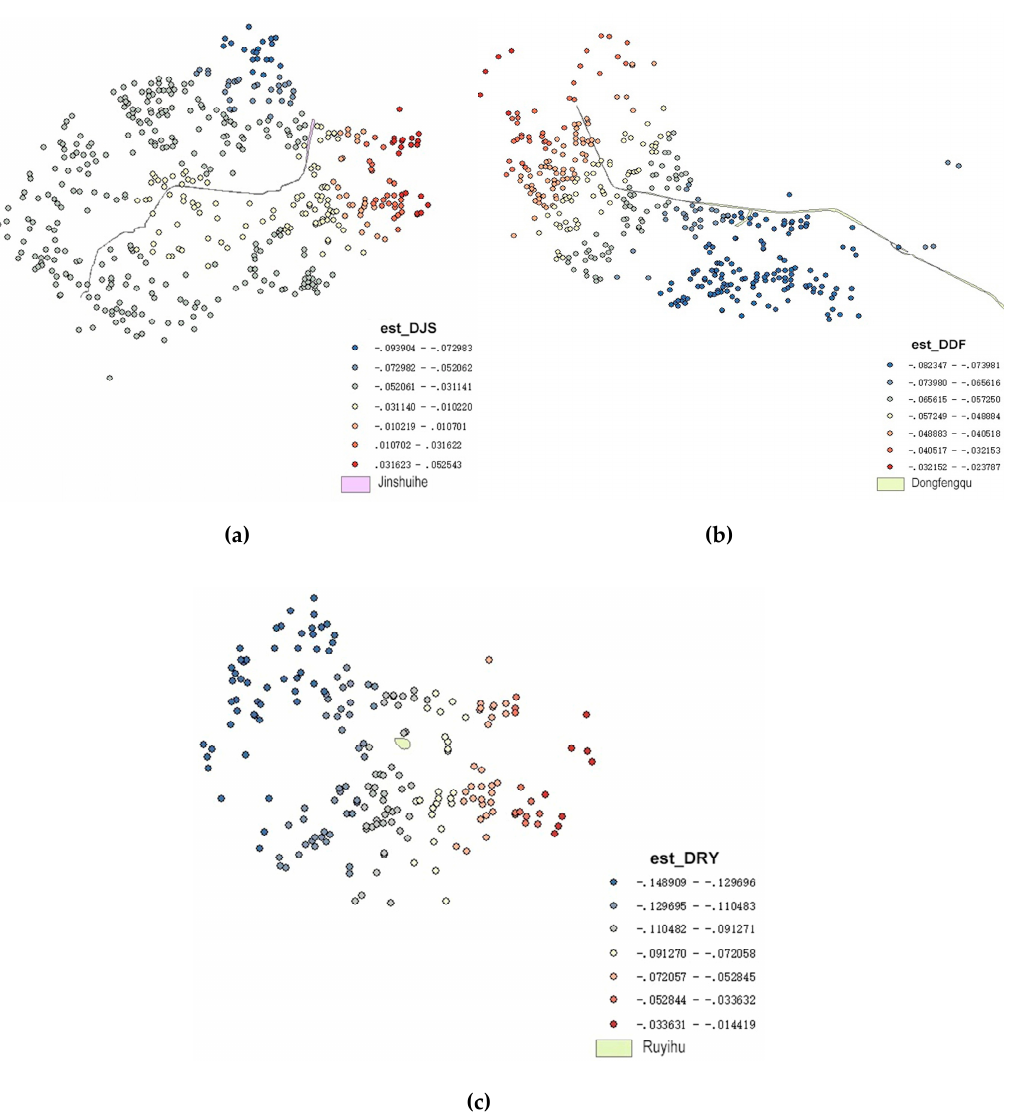
Figure 10. Regression coefficient distribution of distance to Jinshuihe ( a ), Dongfengqu ( b ) and Ruyihu ( c ).